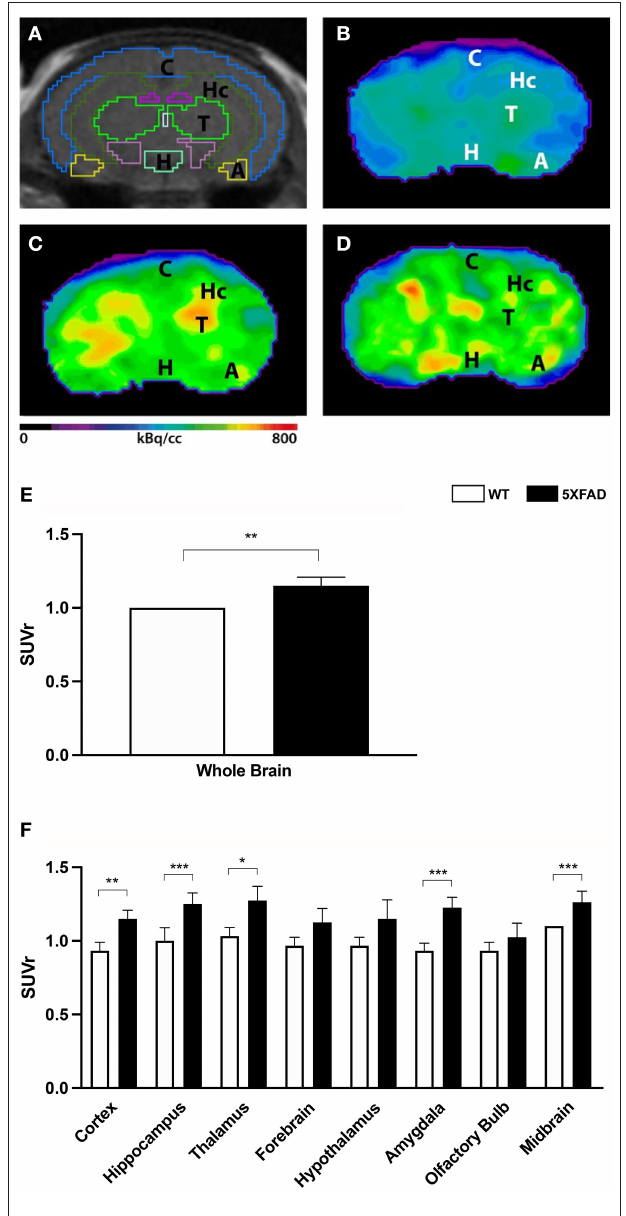
FIGURE 2 | 18F-Florbetaben uptake in 7-month-old female 5XFAD mice and age- and sex-matched WT mice. (A) Mouse brain atlas with predefined brain regions projected on MRI images in coronal view. (B) 18F-Florbetaben-PET images of a 7-month-old WT mouse. (C) 18F-Florbetaben–PET images of a 7-month-old female 5XFAD mouse. (D) 18F-Florbetaben-PET images of a 7-month-old male 5XFAD mouse. 18F-Florbetaben-PET detected increased amyloid deposition in 7-month-old female and male 5XFAD mice compared to WT. (E) 7-month-old female 5XFAD mice showed significantly higher SUVr in the whole brain compared with 7-month-old female WT mice. (F) Differences could be detected in the cortex, hippocampus, thalamus, amygdala, and midbrain. Unpaired t -test; * p < 0.05; ** p < 0.01, *** p < 0.001; data presented as mean + /-